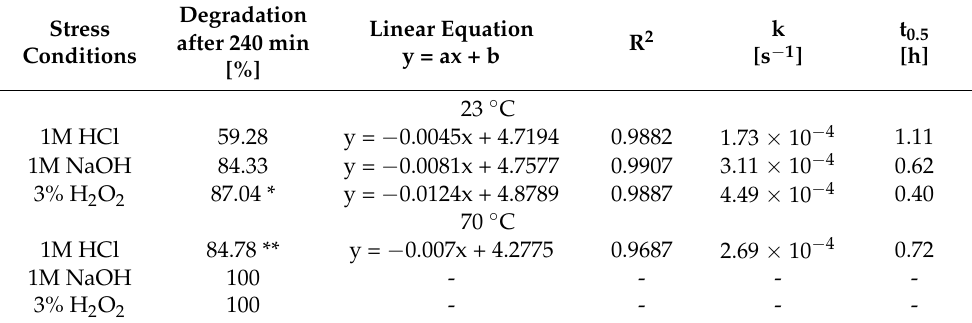
Table 2. The percentage level of degradation and kinetic parameters for the degradation of vildagliptin in solutions.